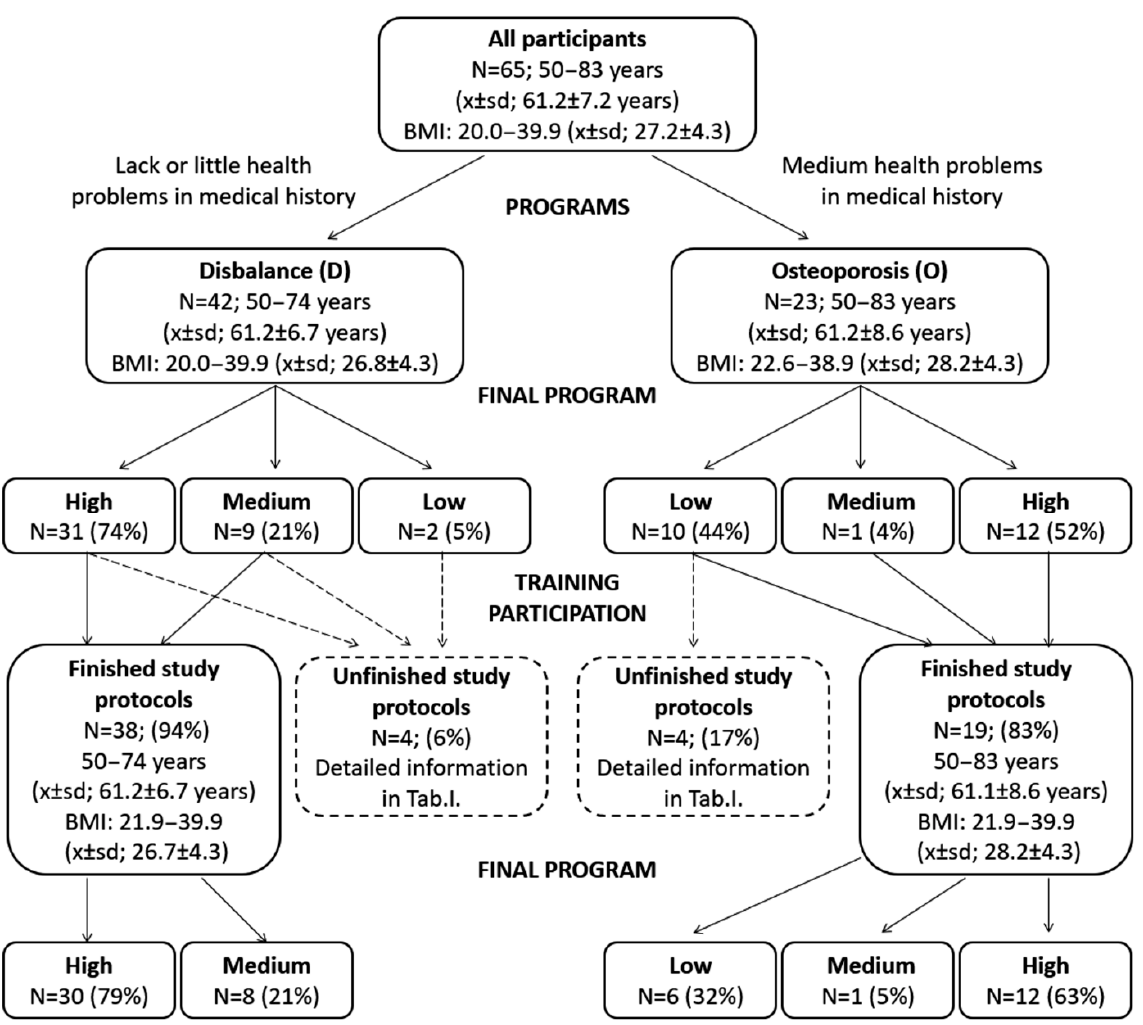
Figure 2. Diagram showing number (N), age and BMI of studied women (x ± sd, mean ± standard deviation), type and final level of the program used, and information about completion or quitting the training. A dashed line represents quitting the training.